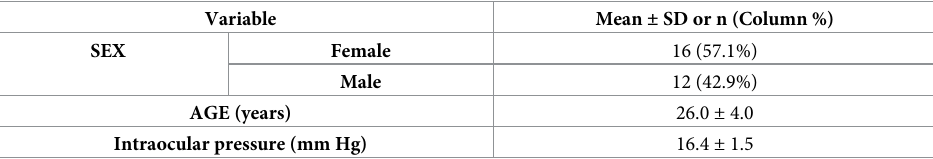
Table 1. Patient characteristis expressed as mean ± SD or n (column